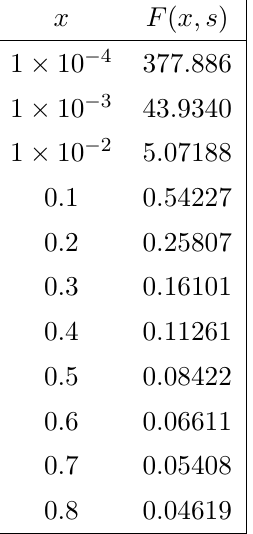
Table 1. The dependence of kernel function F ( x, s ) on x at